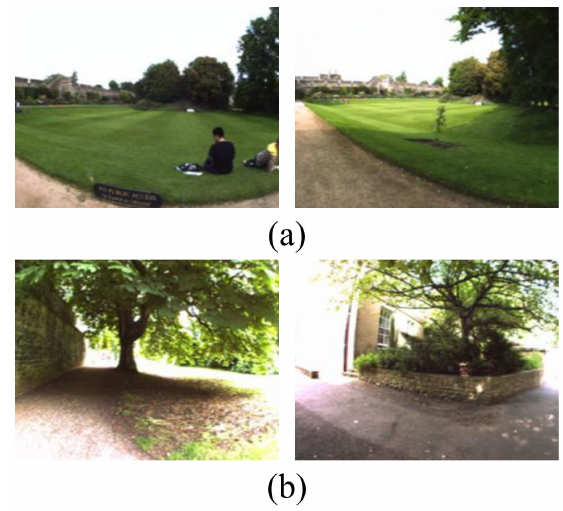
Figure 10. False recognized places ( a ) in area E. ( b ) in area A.